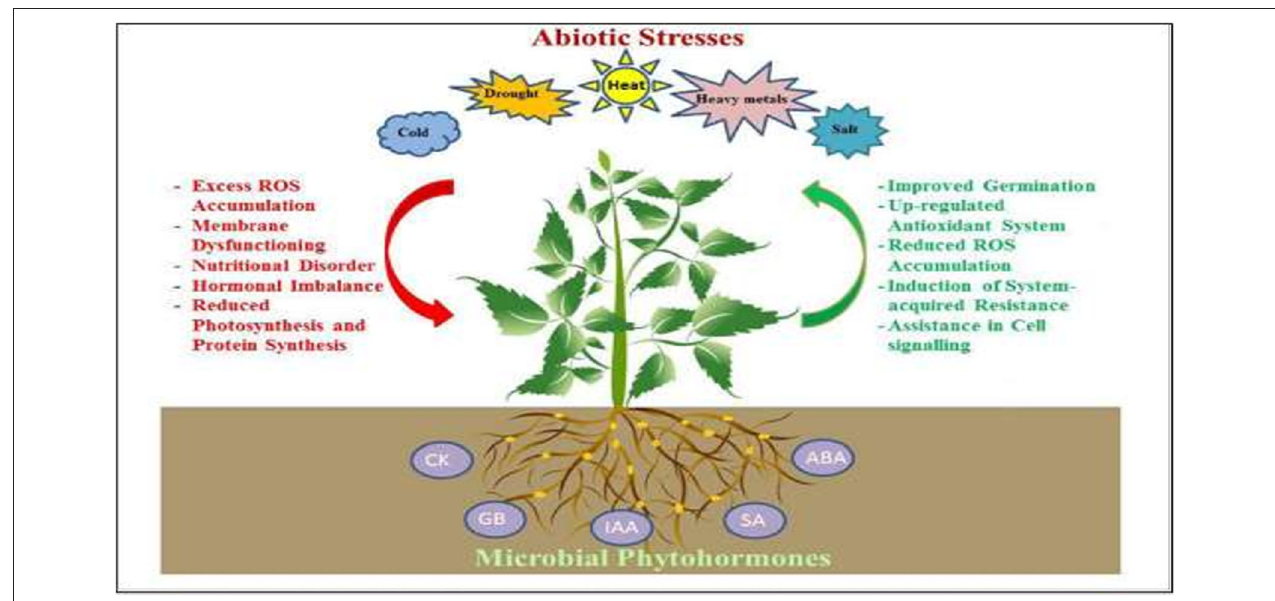
FIGURE 1 | An overview of mechanisms in microbial phytohormone-mediated plant stress tolerance. Several root-associated microbes produce CK, GA, IAA, SA, and ABA, which help plants to withstand stress by enhancing their antioxidant potential, by up-regulation of the antioxidant system and by the accumulation of compatible osmolytes thus reducing oxidative stress-induced damage; improving photosynthetic capacity and membrane stability; promoting cell division and stomatal regulation; stimulating the growth of root system, and acquisition of water and nutrients.